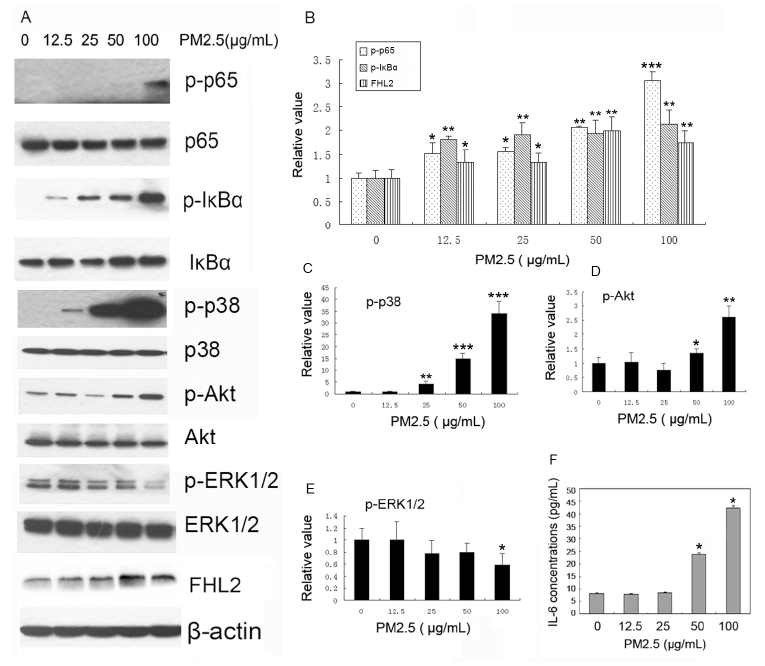
Figure 1. Activation of NF- κ B and FHL2 upregulation by PM2.5. ( A ) Cells were incubated with 0, 12.5, 25, 50, and 100 µg/mL PM2.5 for 24 h, and phosphorylated p65 (p-p65), p65, phosphorylated I κ B α (p-I κ B α ), I κ B α , phosphorylated p38(p-p38), p38, phosphorylated Akt (p-Akt), Akt, phosphorylated ERK1/2 (p-ERK1/2), ERK1/2, FHL2 , and β -actin were detected in PM2.5-treated mouse aortic endothelial cells (MAECs). ( n = 3); ( B – E ) Band quantifications for western blot analysis. * p < 0.05; ** p < 0.01; *** p < 0.001; ( F ) IL-6 expression detected in MEAC supernatant treated with